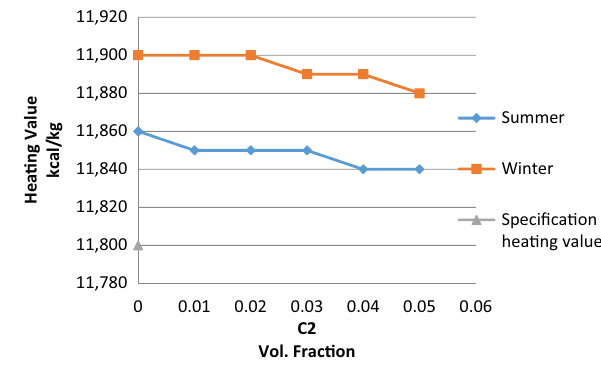
Table 5 Flow controller set point for dynamic model